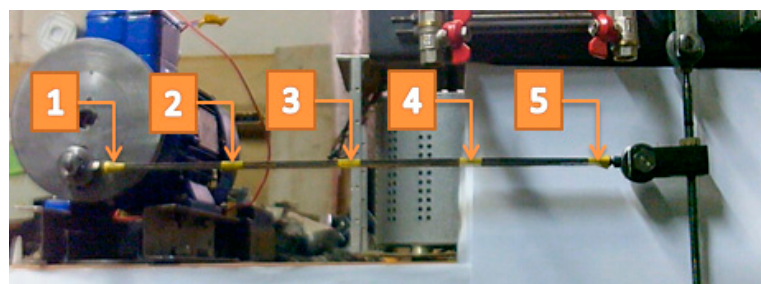
Figure 6. The studied mechanism and the positioning of the markers on the bar .